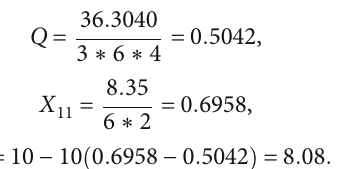
Table 17: Expected completion time- t